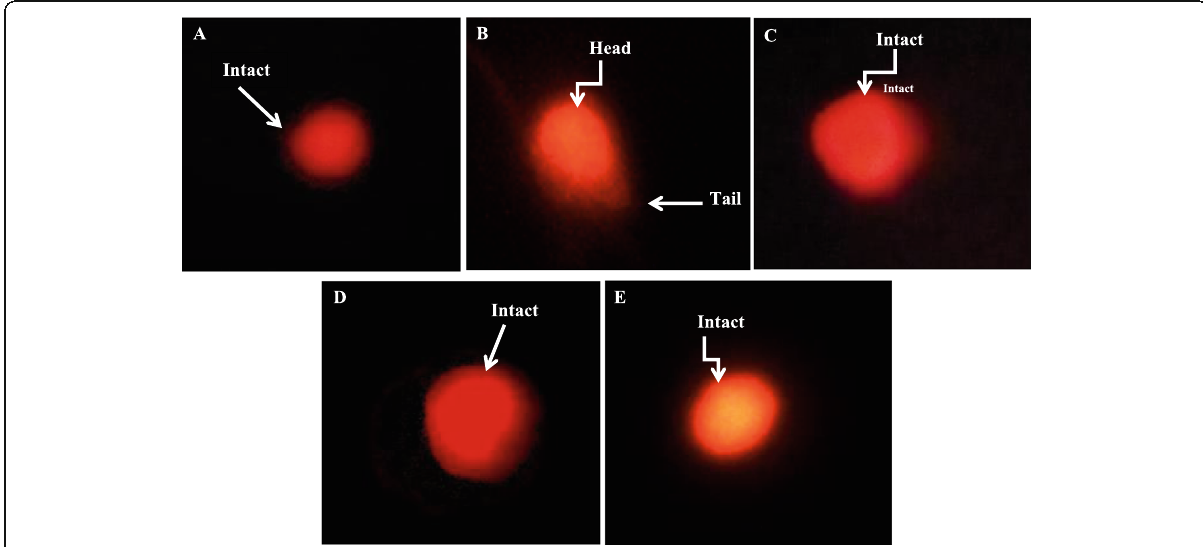
Fig. 2 Photomicrograph (× 40) of sperm DNA damage determined by comet assay in different treatment groups after 30 days of treatment showing control group with more intact DNA ( a ), Mercury group having comets with short tails ( b ), vitamin C-treated group ( c ), and extract- treated group ( d ) representing somewhat intact DNA compared with the treated